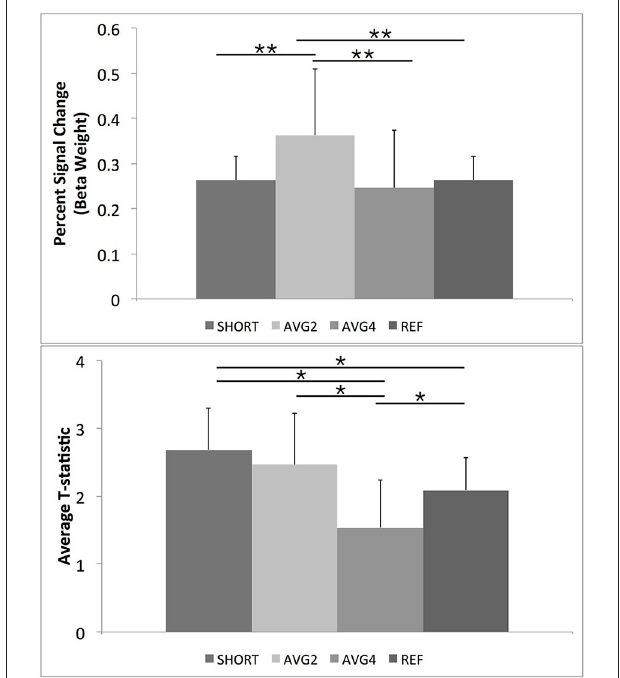
FIGURE 6 | Post-hoc results for repeated measures ANOVAs for BOLD percent signal change and GLM-calculated T -statistics for the ROI mask containing only task-related regions extracted from the FSL Harvard-Oxford Atlas. As described in the text, SHORT, TR = 700 ms; AVG2, TR effective = 1440 ms; AVG4, TR effective = 2800 ms; REF, TR = 1440 ms. Percent signal change values were calculated from the beta weights estimated during the GLM. **Indicates a post-hoc difference at p < 0.05, Bonferroni corrected for comparing across the four different EPI sequences. *Indicates a post-hoc difference at p < 0.05,